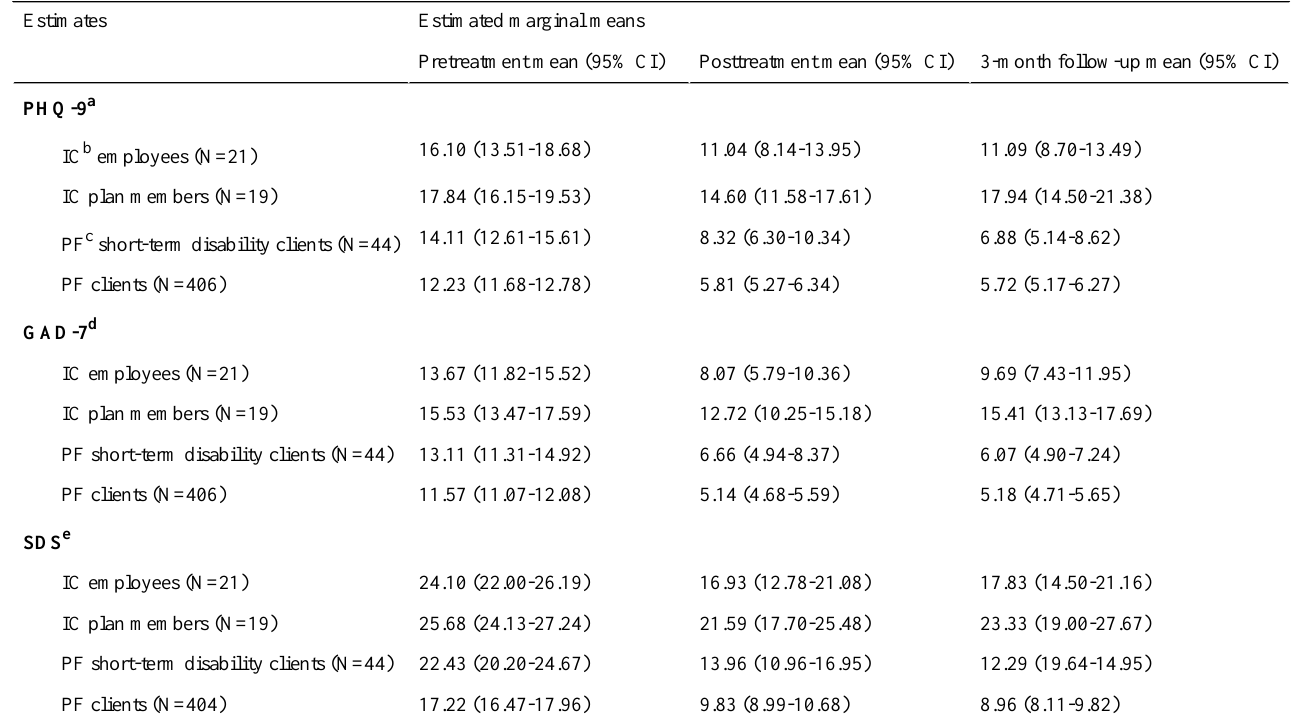
Table 2. Estimated marginal means and 95% CI for primary outcomes separated by sample. Estimated marginal